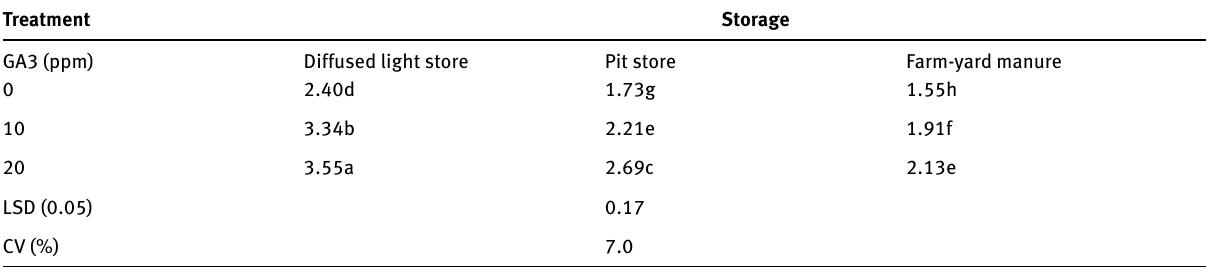
Ethiopia Treatment